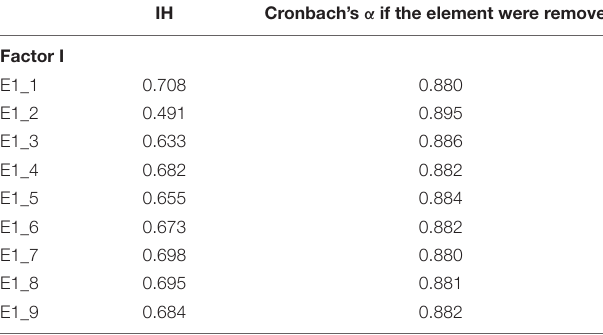
TABLE 6 | Exploratory factor analysis.